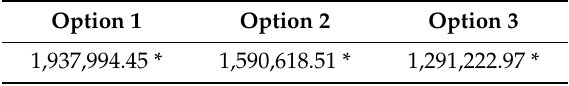
Table 1. Statement of cost estimates (excluding value-added tax (VAT)) for the Implementation of the scope of work provided for in options 1, 2, 3.